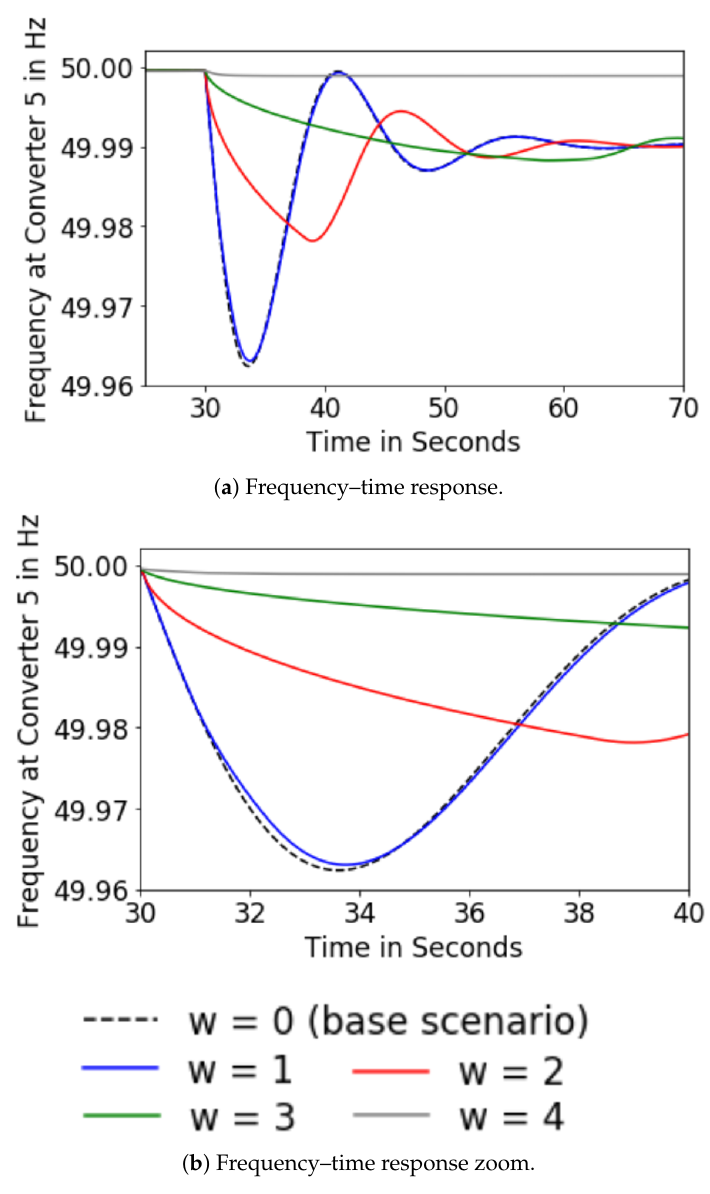
Figure 11. Time response scenario